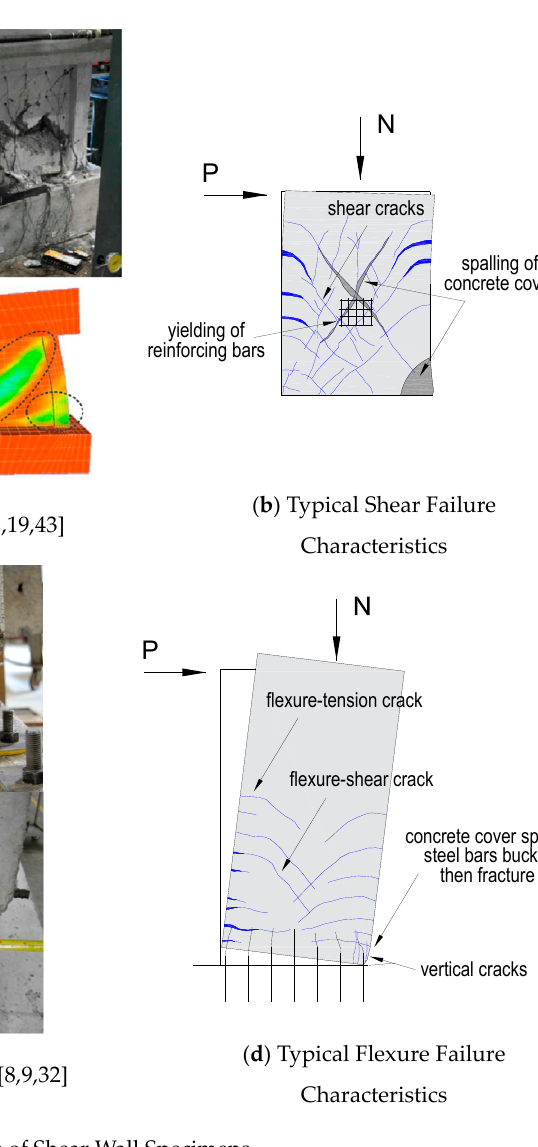
Figure 9. Failure Modes of Shear Wall Specimens.